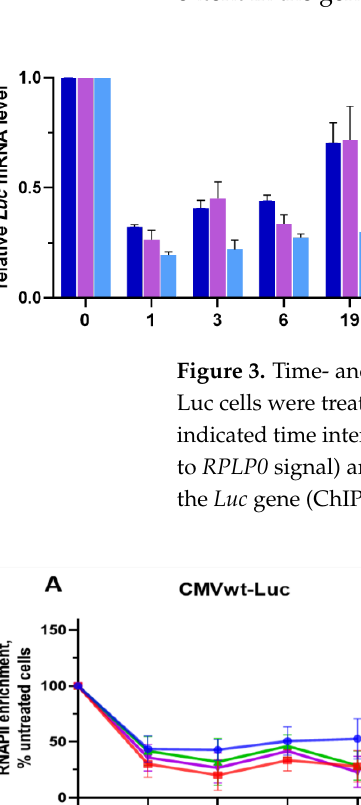
Figure 3. Time- and size-dependent restoration of transcripts after OA washing. HEK293T-CMVwt- Luc cells were treated 100 nM OA for 3 h, washed with saline, and incubated in OA-free medium for indicated time intervals. ( A ) qRT-PCR analysis of Luc mRNAs of different length. Values (normalized to RPLP0 signal) are relative to those prior to OA washing (0 h). ( B ) Abundance of total RNAPII on the Luc gene (ChIP assays).